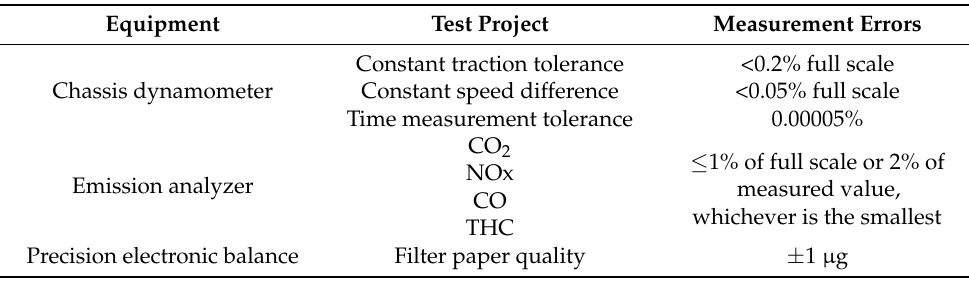
Table 3. Uncertainties of measured parameters [60].